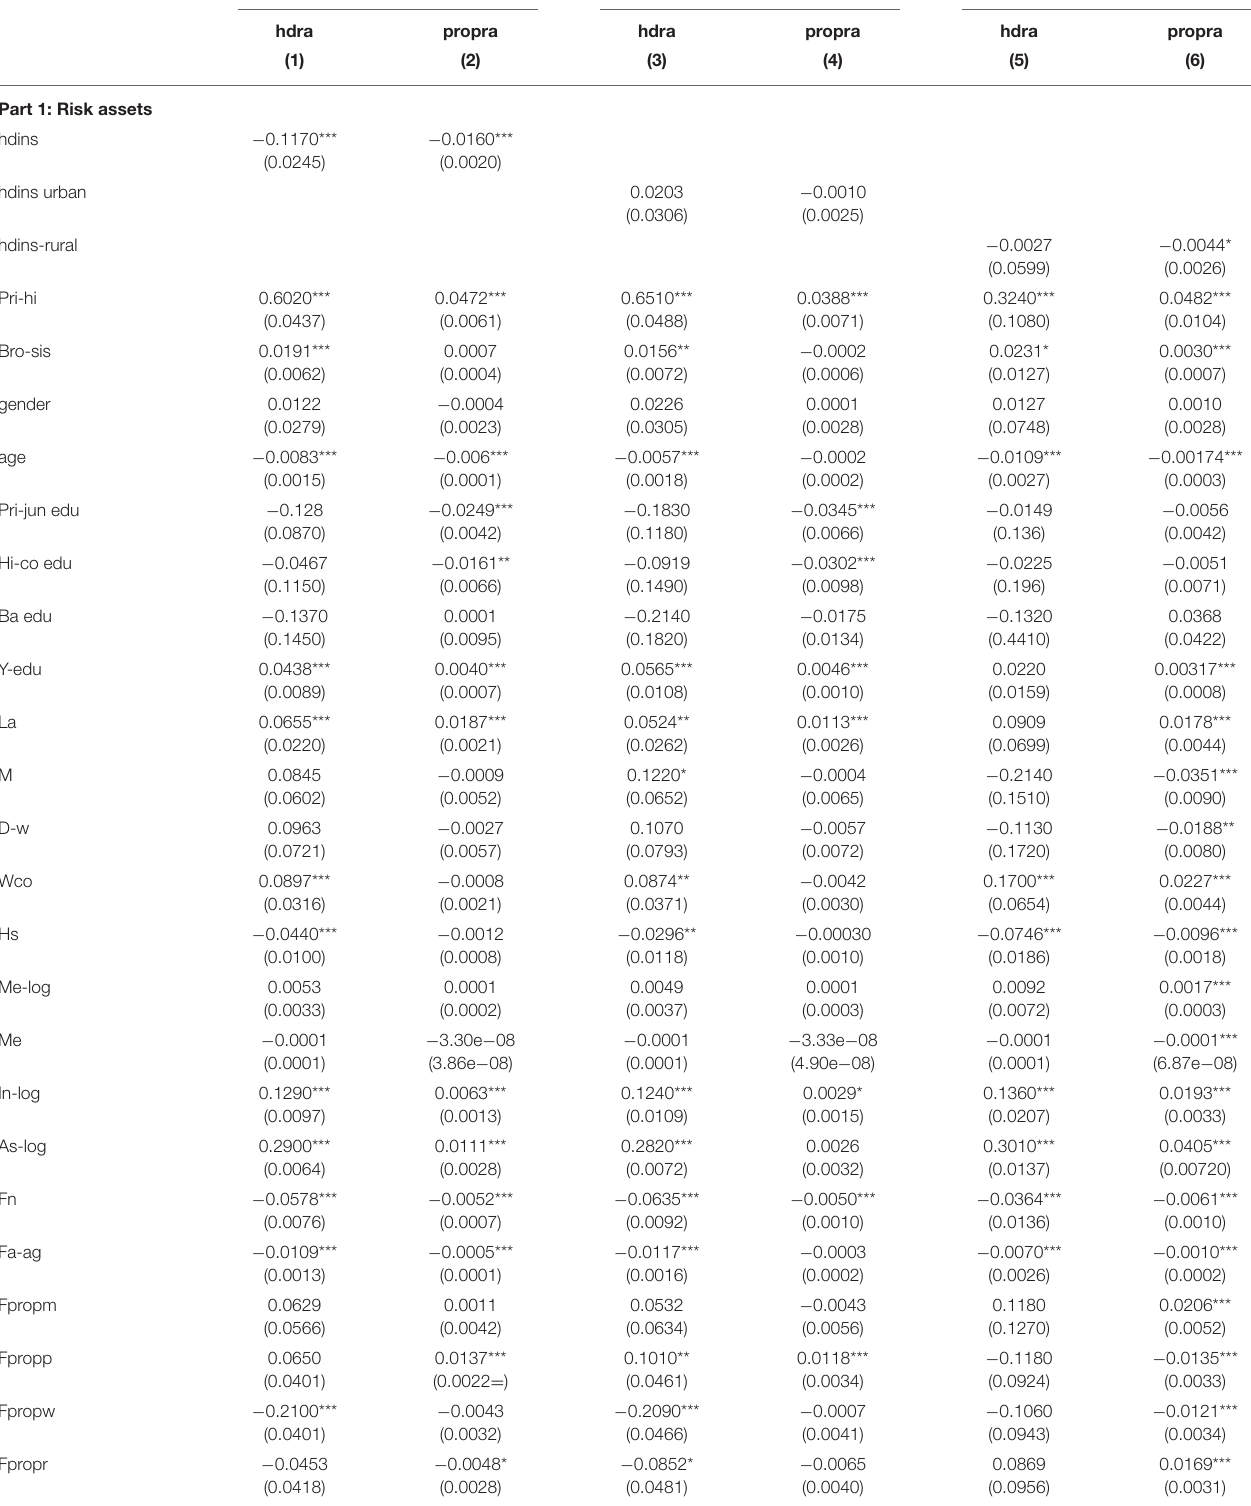
TABLE 5 | Benchmark regression (replacing definitions of financial